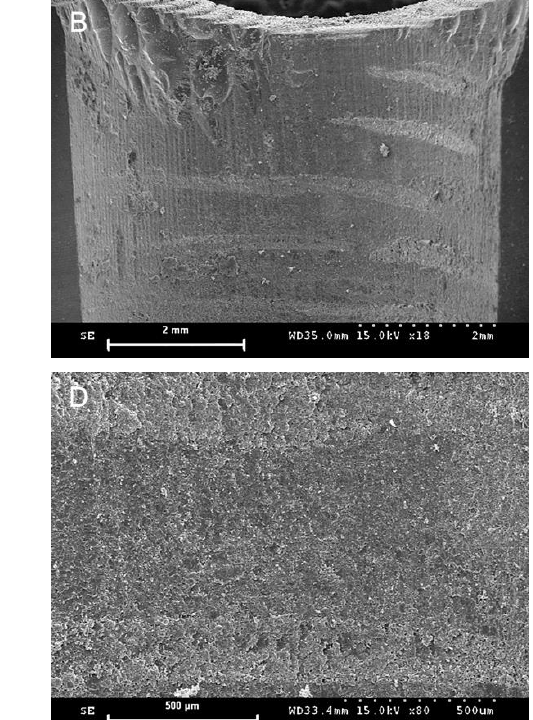
Figure 7. Representative scanning electron microscopic images. Cross-sectional view of a sleeve insert from a preoperative ( A ) and a postoperative ( B ) image from the MSI group at a lower magnification (18×). Cross-sectional view of a sleeve insert from a preoperative ( C ) and a postoperative ( D ) image from the MSI group at a higher magnification (80×).